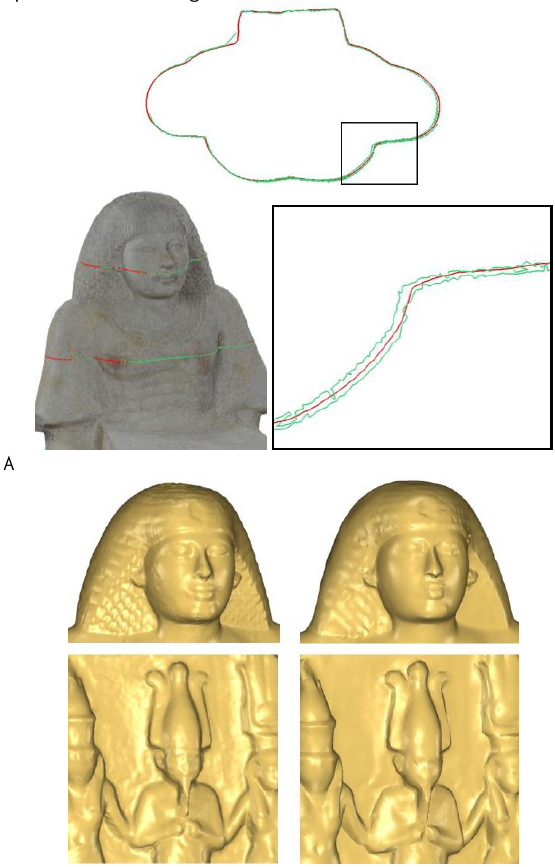
Figure 5. Insignificant level of roughness computed on the photogrammetric cloud. (less than 0.5 mm almost throughout the cloud) Once aligned, several section profiles have been also extracted from both the cloud (Figure 6). Measuring samples of residuals among the photogrammetric cloud, assumed as the reference cloud, and the freestyle one, we have been able to estimate that the second one has discards of 1-2 mm due to alignment operation and its roughness.